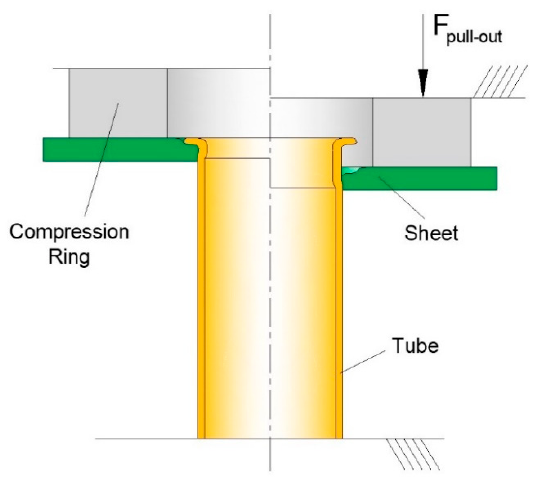
Figure 5. Schematic representation of a destructive pull ‐ out test.